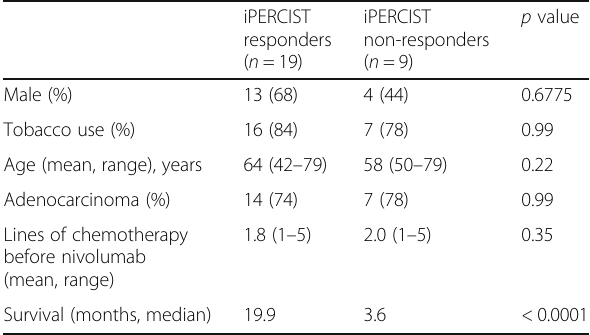
responding to nivolumab treatment according to iPERCIST